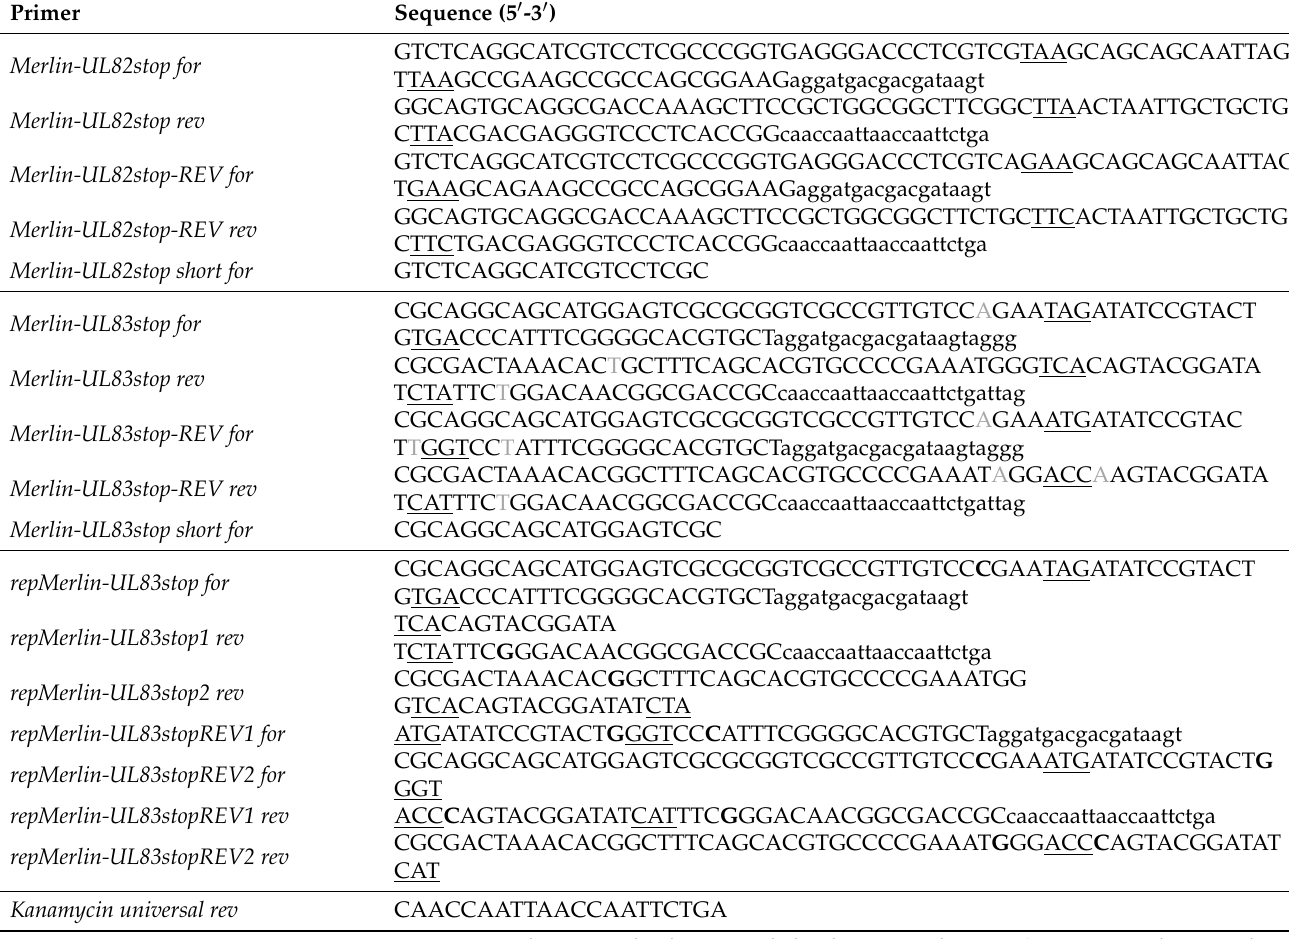
Table 1. Primers used for the generation of mutant BAC genomes. Sequence (5 (cid:48) -3 (cid:48)